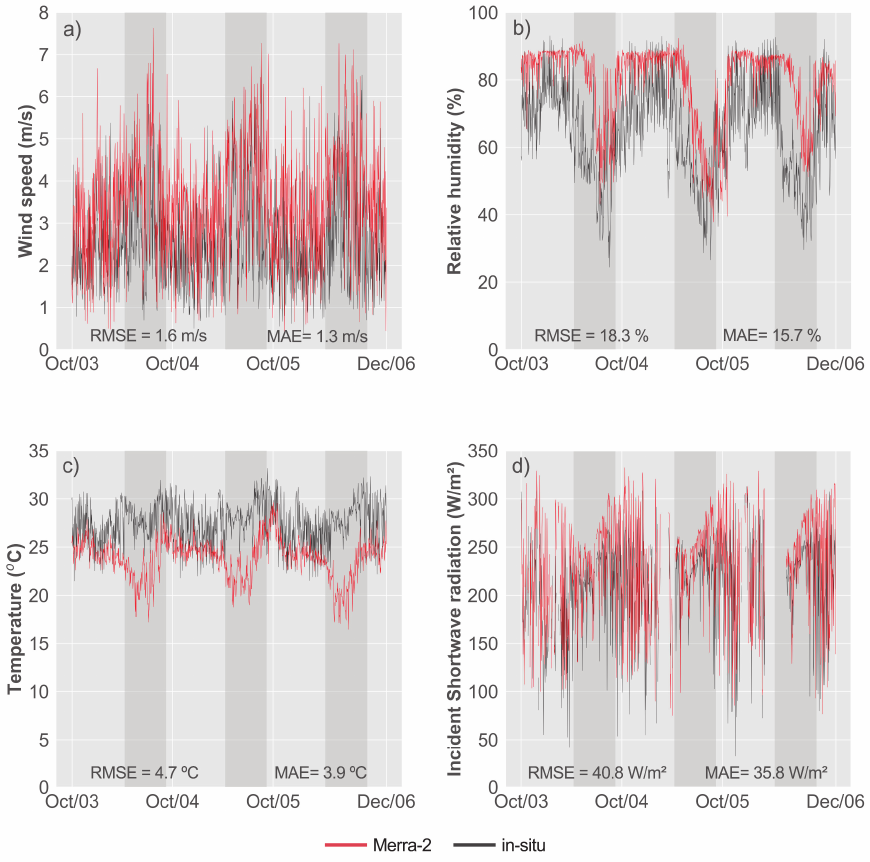
Comparison of hourly (average between 10:00 and 11:00 am) wind speed ( u ) ( a ), relative humidity ( RH ) ( b ), air temperature ( T a ) ( c ), and daily incident shortwave radiation ( R s ) ( d ) between MERRA-2 and meteorological measurements at the JAV site. Shaded areas represent the climatological dry season.